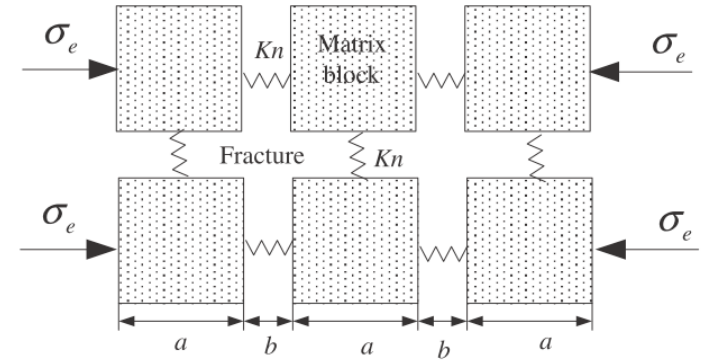
Figure 1. Dual-porosity medium [26] ( a , b , K n , and σ e represent the cubic matrix length, the width of the cleats separating the matrix blocks, facture stiffness, and effective stress, respectively).